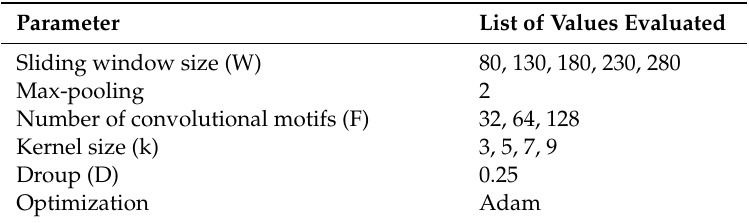
Table 1. DeepPred-SubMito structure